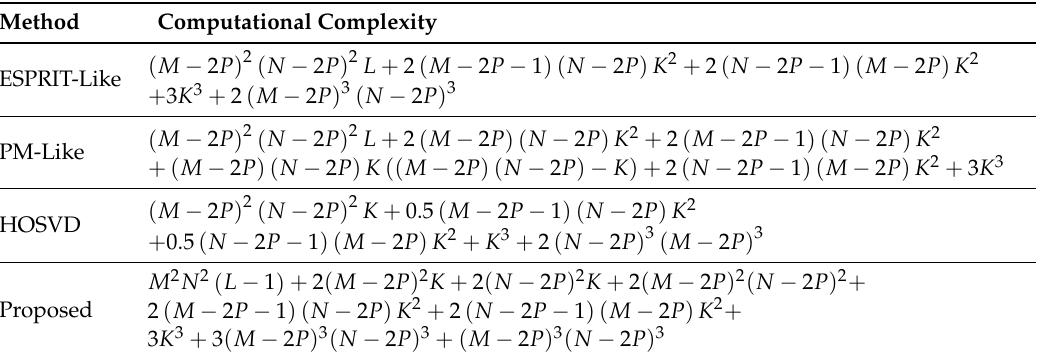
Table 1. Comparison of the complexity in joint DOD and DOA